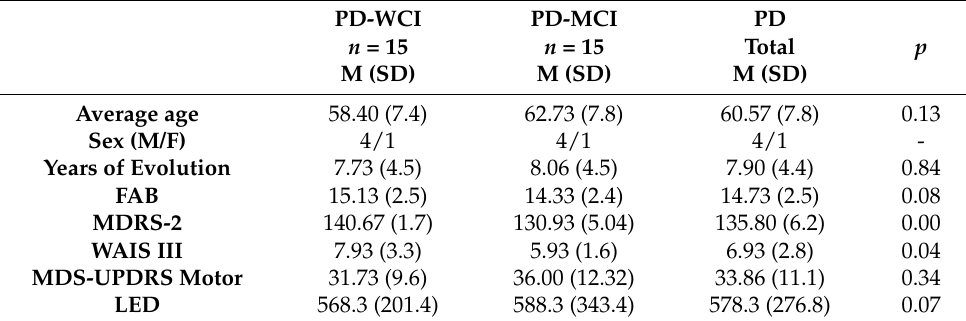
Table 1. Clinical and demographic characteristics of patients with Parkinson’s disease.